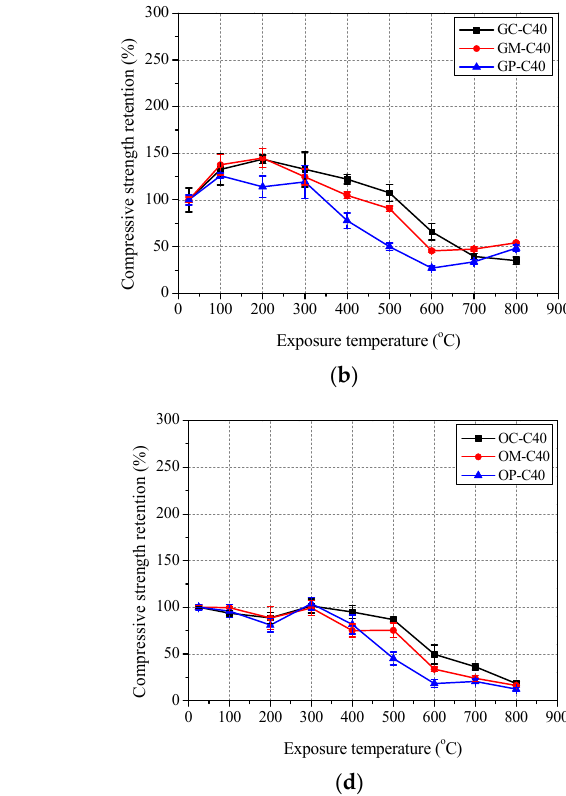
( a ) geopolymer-C30; ( b ) geopolymer-C40; ( c ) geopolymer-C50 and ( d ) OPC-C40.